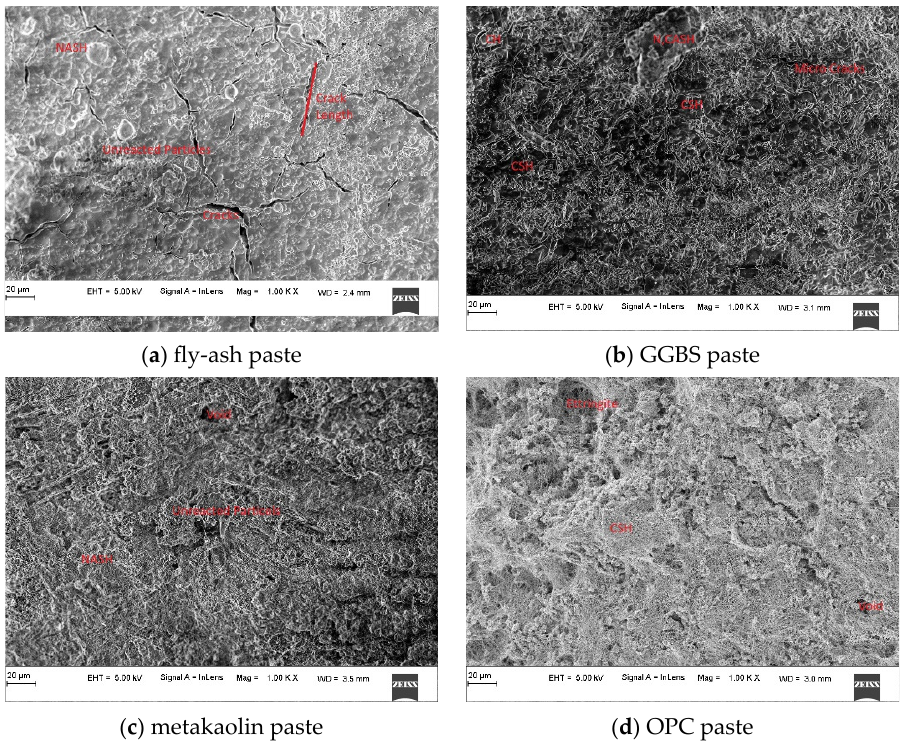
Figure 9. Alkali-activated paste at 7 days with magnification 1KX.